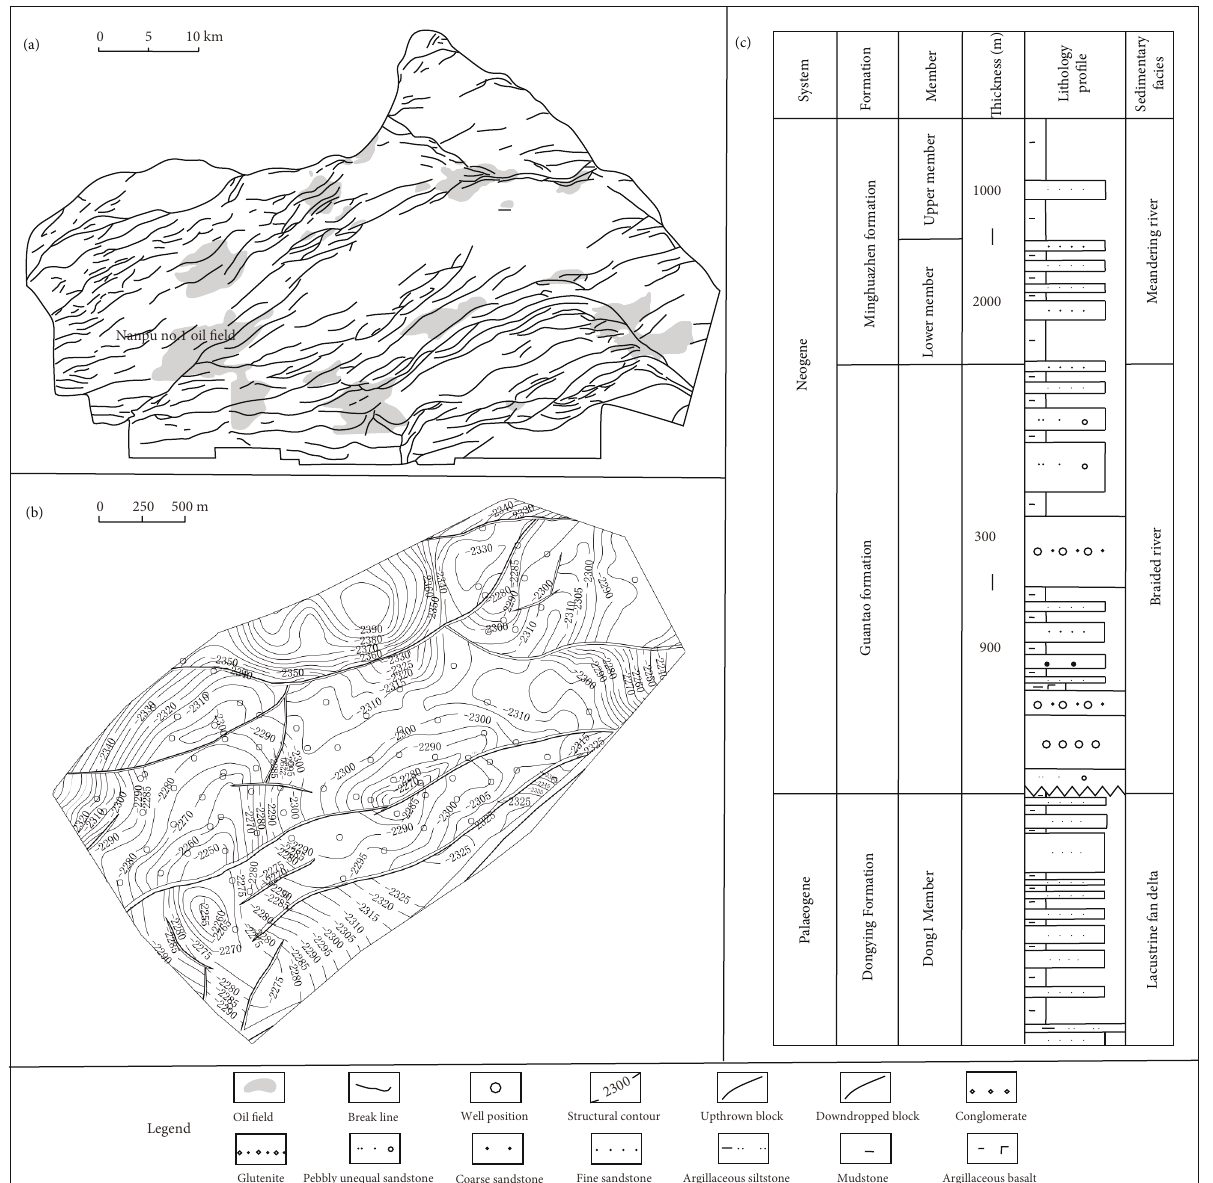
Figure 2: Structural location and comprehensive histogram of the study area: (a) structural location map of Nanpu Depression; (b) structural map of Nanpu 1-29 Area, located in Nanpu No. 1 oil fi eld; (c) comprehensive histogram of Neogene in Nanpu Depression, the sedimentary sequences of a braided river and a meandering river were